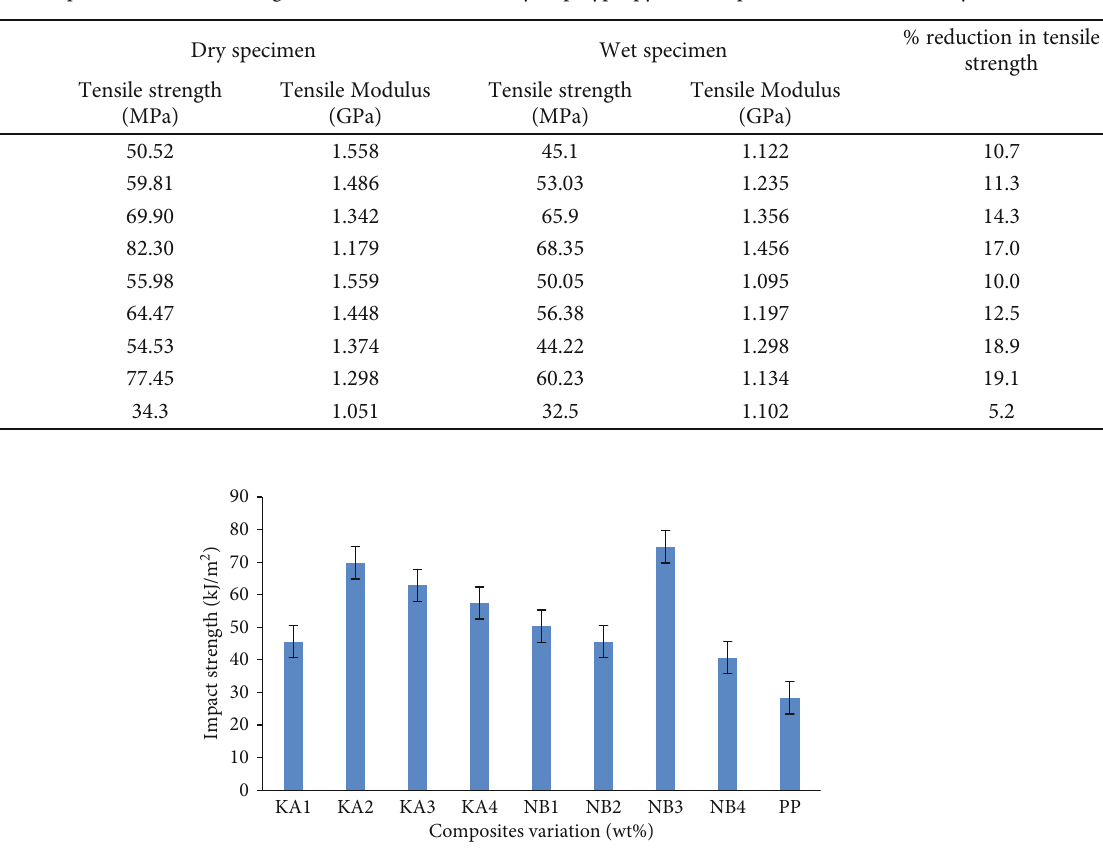
Figure 5: Comparison of impact strength of KOH- and NaOH-treated fi ber-reinforced composites and pure PP. Table 4: Comparison of Impact strength of polypropylene composites under wet and dry conditions.